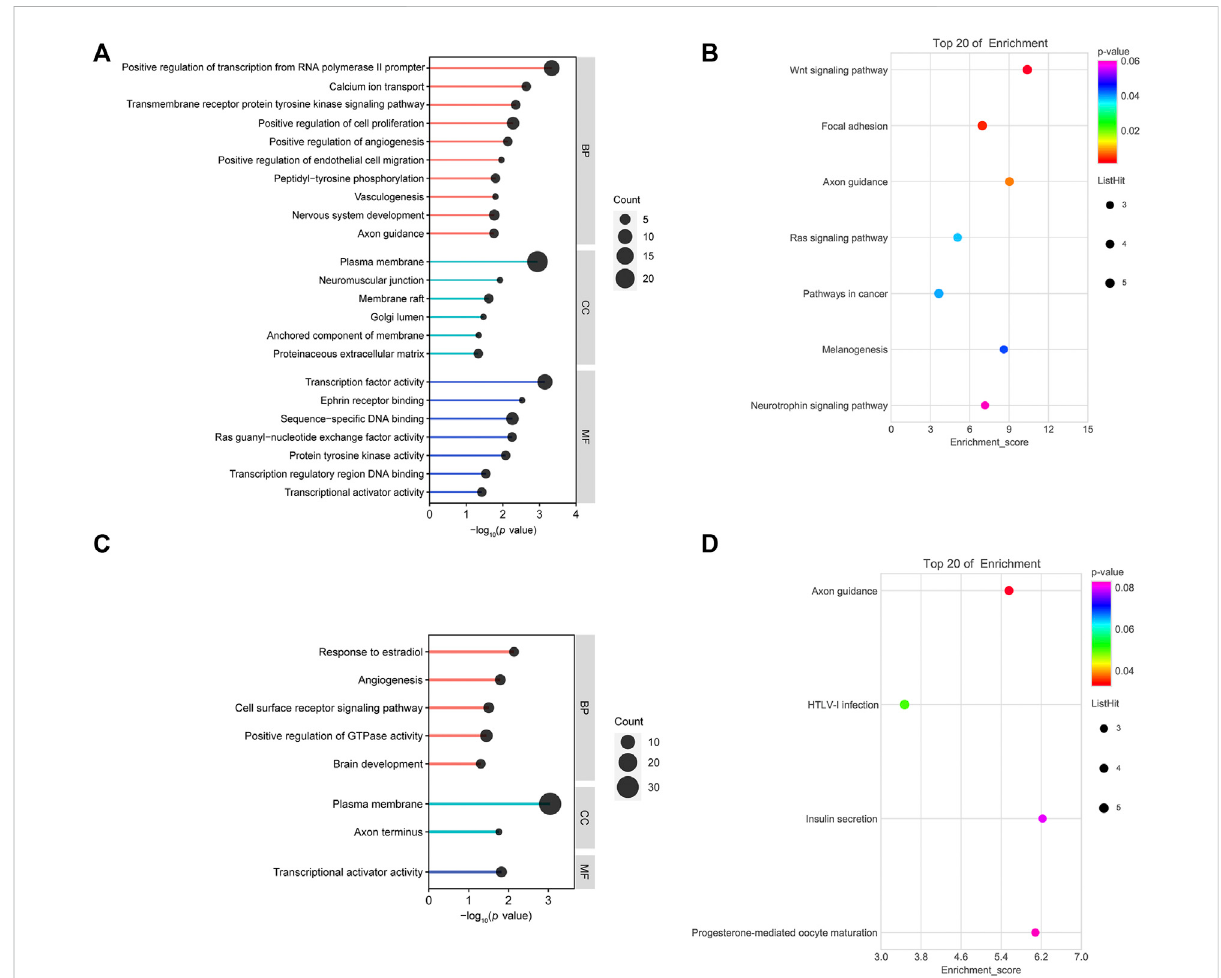
FIGURE 3 Functional analysis of overlapping genes: (A) gene ontology (GO) analysis of downregulated overlapping genes. (B) Kyoto Encyclopedia of Genes and Genomes (KEGG) pathway analysis of downregulated overlapping genes. (C) GO analysis of upregulated overlapping genes. (D) KEGG pathway analysis of upregulated overlapping